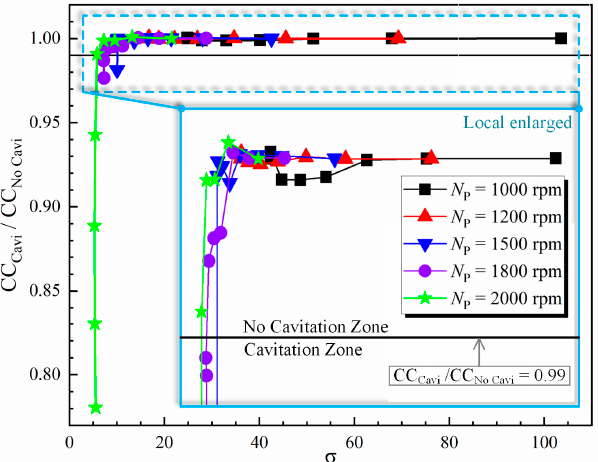
Figure 19. The capacity constant ratio with regard to cavitation number under various N P .